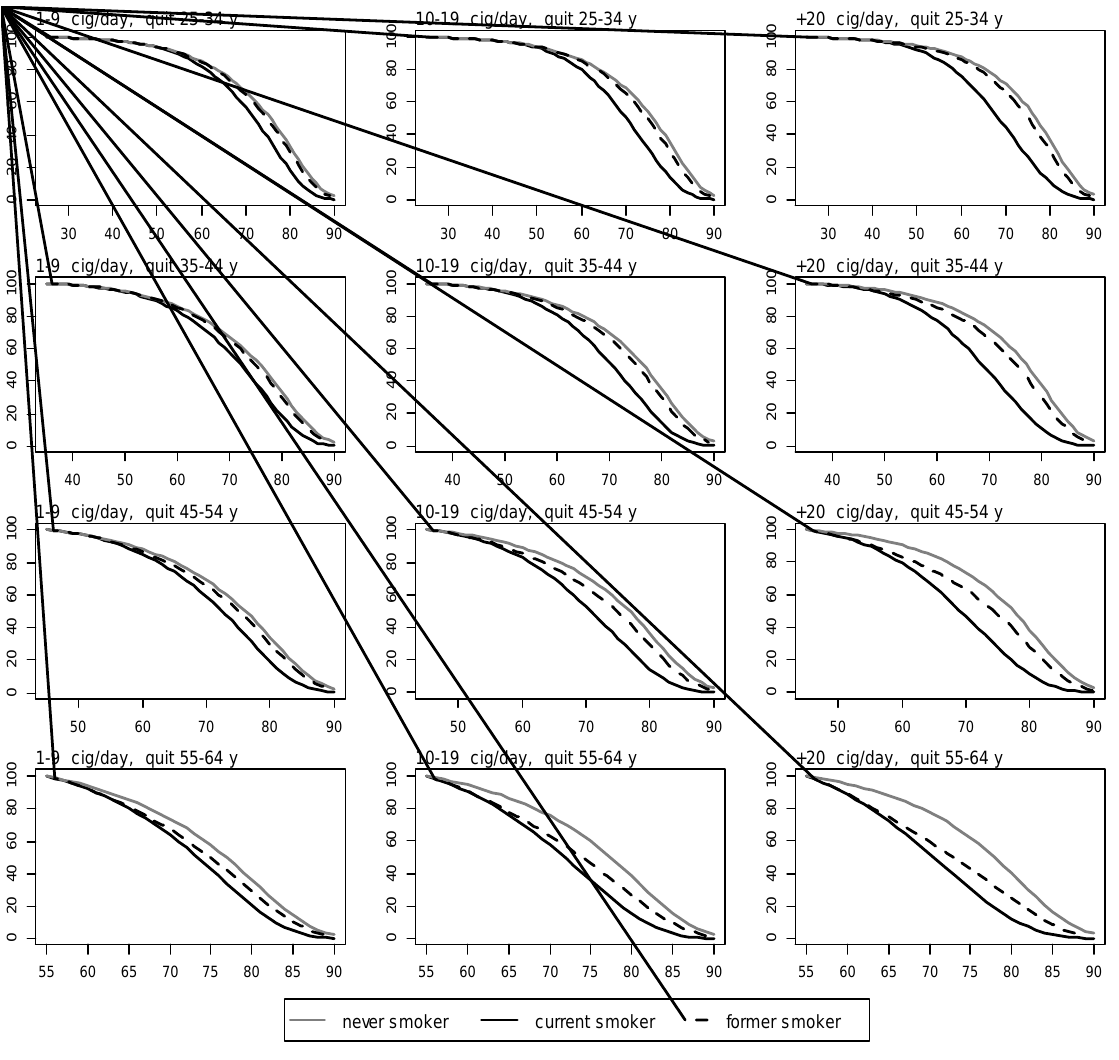
2. Page 2400, Figure 4. Due to the changes in Figure 3, replace: Figure 4. Survival for never, current, and former women smokers by number of cigarettes smoked per day and age of quitting. y axis: proportion of survival. x axis: age in